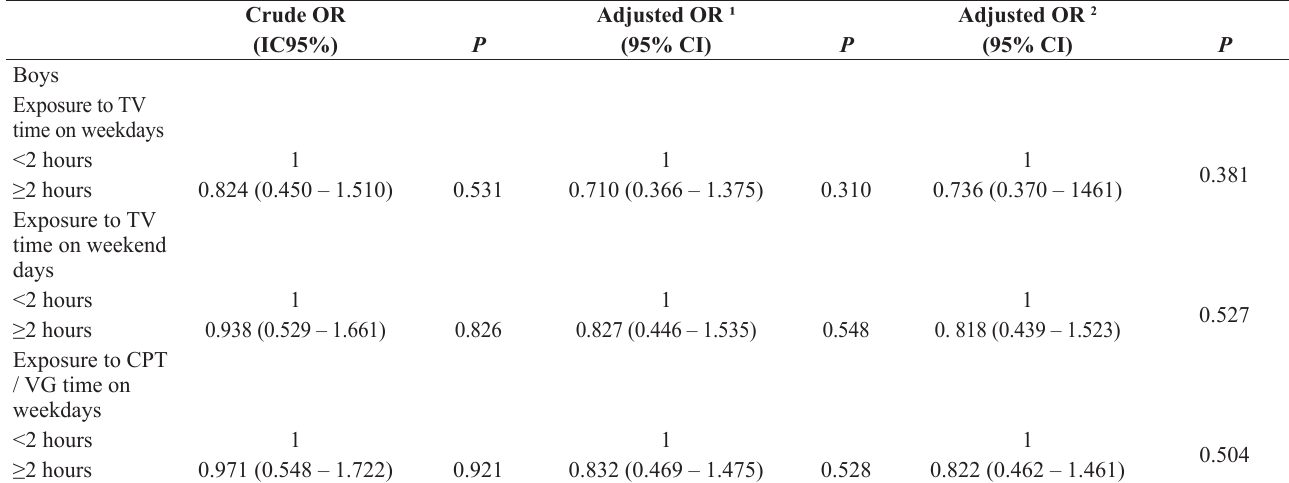
Table 3. Odds ratio for excess screen time (≥2 hours) of adolescents in the intervention group, using the control group in the “MEXA-SE” study as reference, Florianópolis, SC / Brazil,